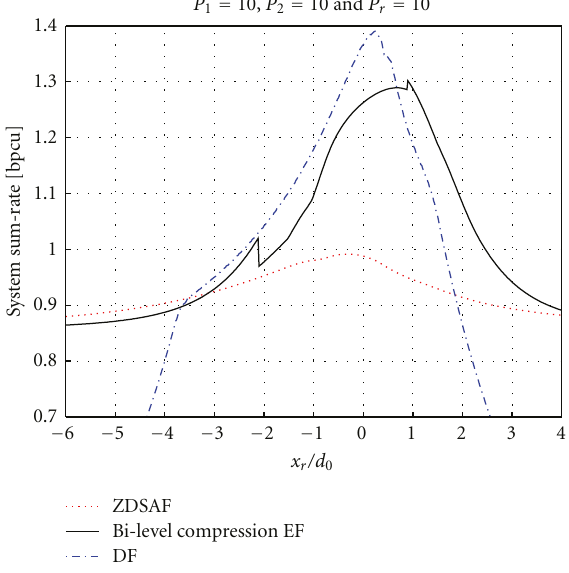
Figure 3: Achievable system sum-rate versus x r (abscissa for the relay position) for a fixed y r ( y r = 0 . 5 d 0 ), with AF, DF and bi-level EF.